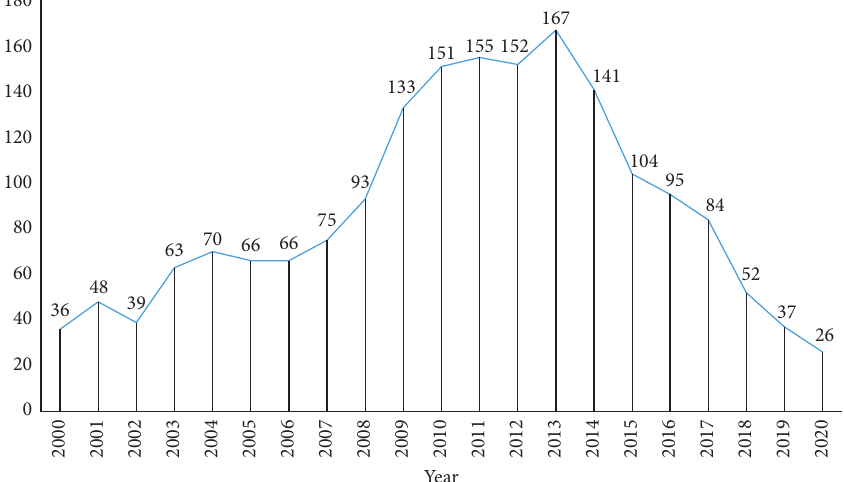
Figure 3: The trend of keyword, competitive sports.